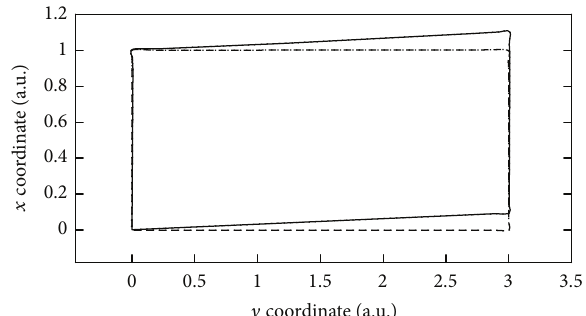
Figure 2: Deformed shape of the panel (deformation is magnified by multiplying factor of